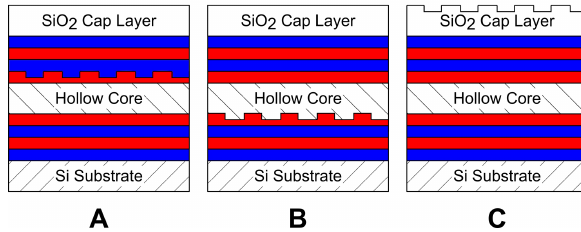
Fig. 7. Showing the locations in the ARROW structure where periodic modulations may be introduced (A) above the core (B) below the core (C) in the capping layer. Fig. 8. Reflectivity of a Bragg mirror in an ARROW structure shown as a function of (A) number of periods in the grating, and (B) the wavelength for a 10000 period grating. In this particular design the grating was optimized for wavelengths corresponding to the 133 Cs D2 line around 852 nm. The dash dotted red and dashed green lines in (A) refer to the maximum reflectivity of the grating calculated using the average grating penetration depth estimate and the MSE respectively. The dashed lines in (B) refer the estimated bandgap of this mirror.